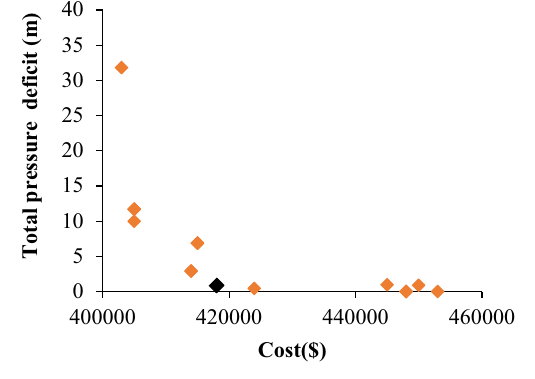
Fig. 3 Front of the non-dominated solutions of the two-loop no-leak WDN